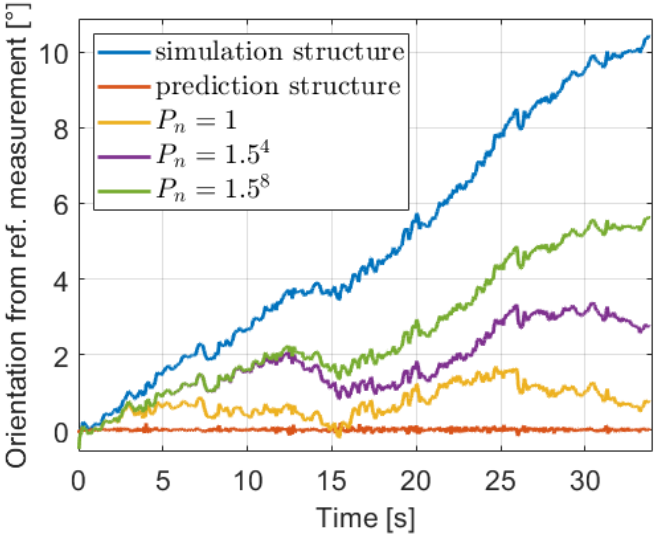
Figure 15. Orientation with various